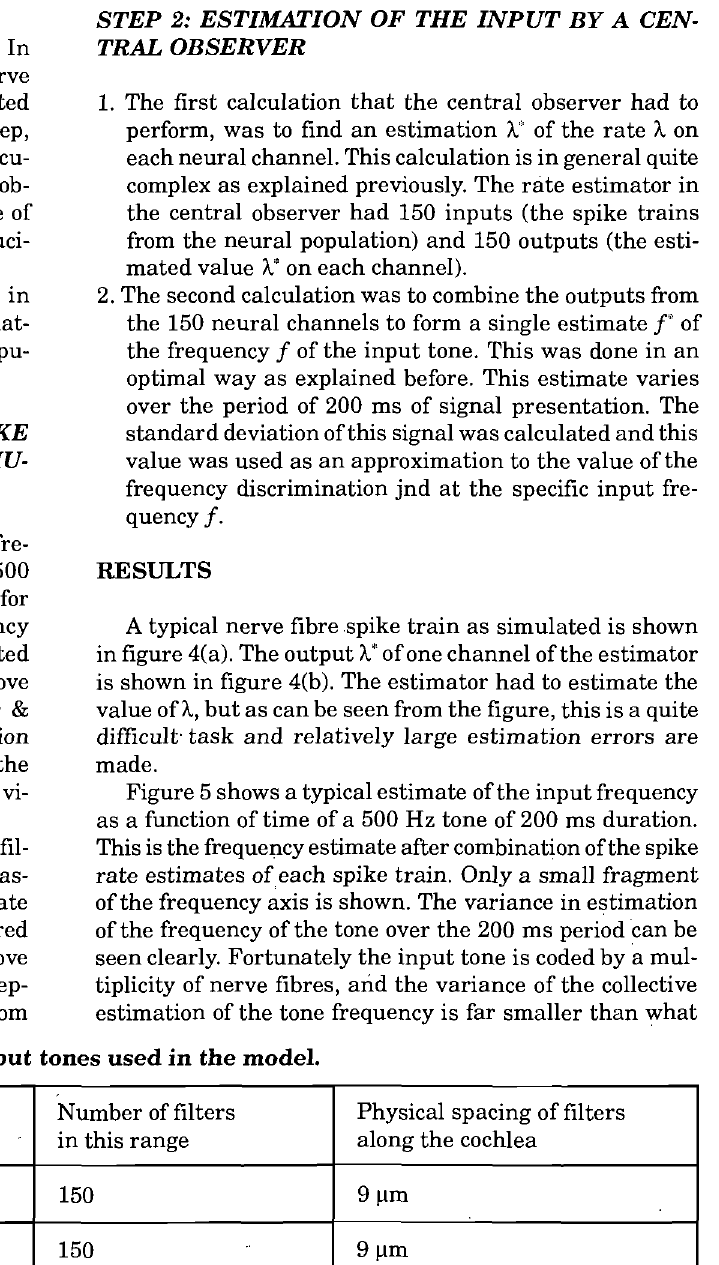
TABLE 1. Ranges of critical bands around the input tones used in the model. Input